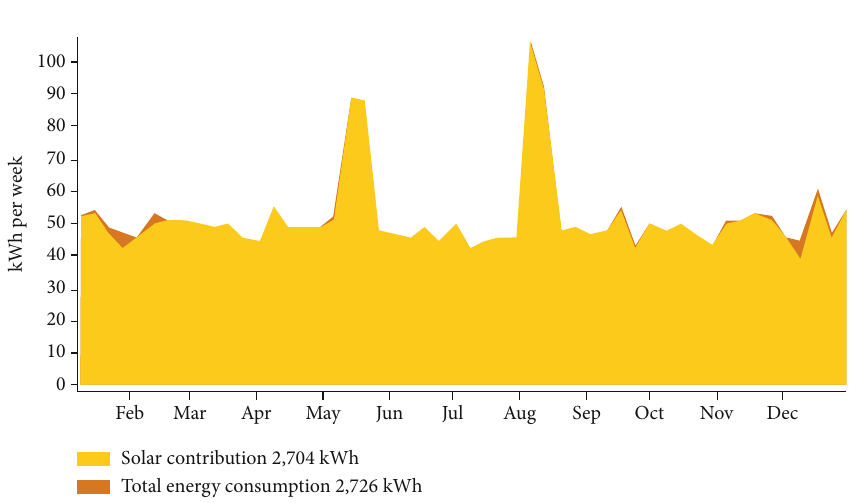
Figure 8: Solar energy consumption as a percentage of total consumption for Sesheke Town.